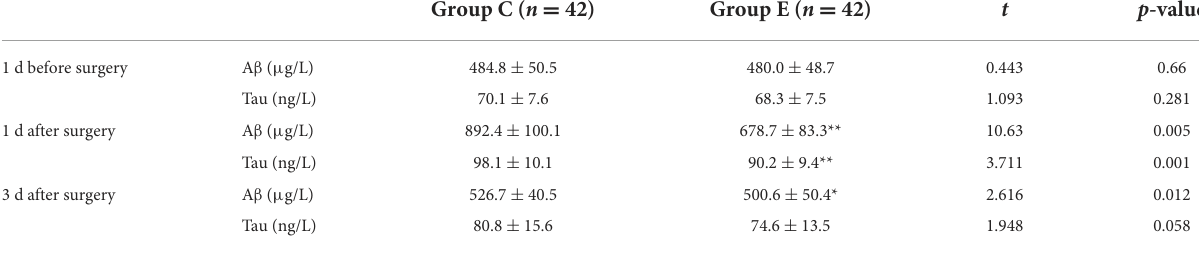
TABLE 6 Comparison of the expression levels of A β and